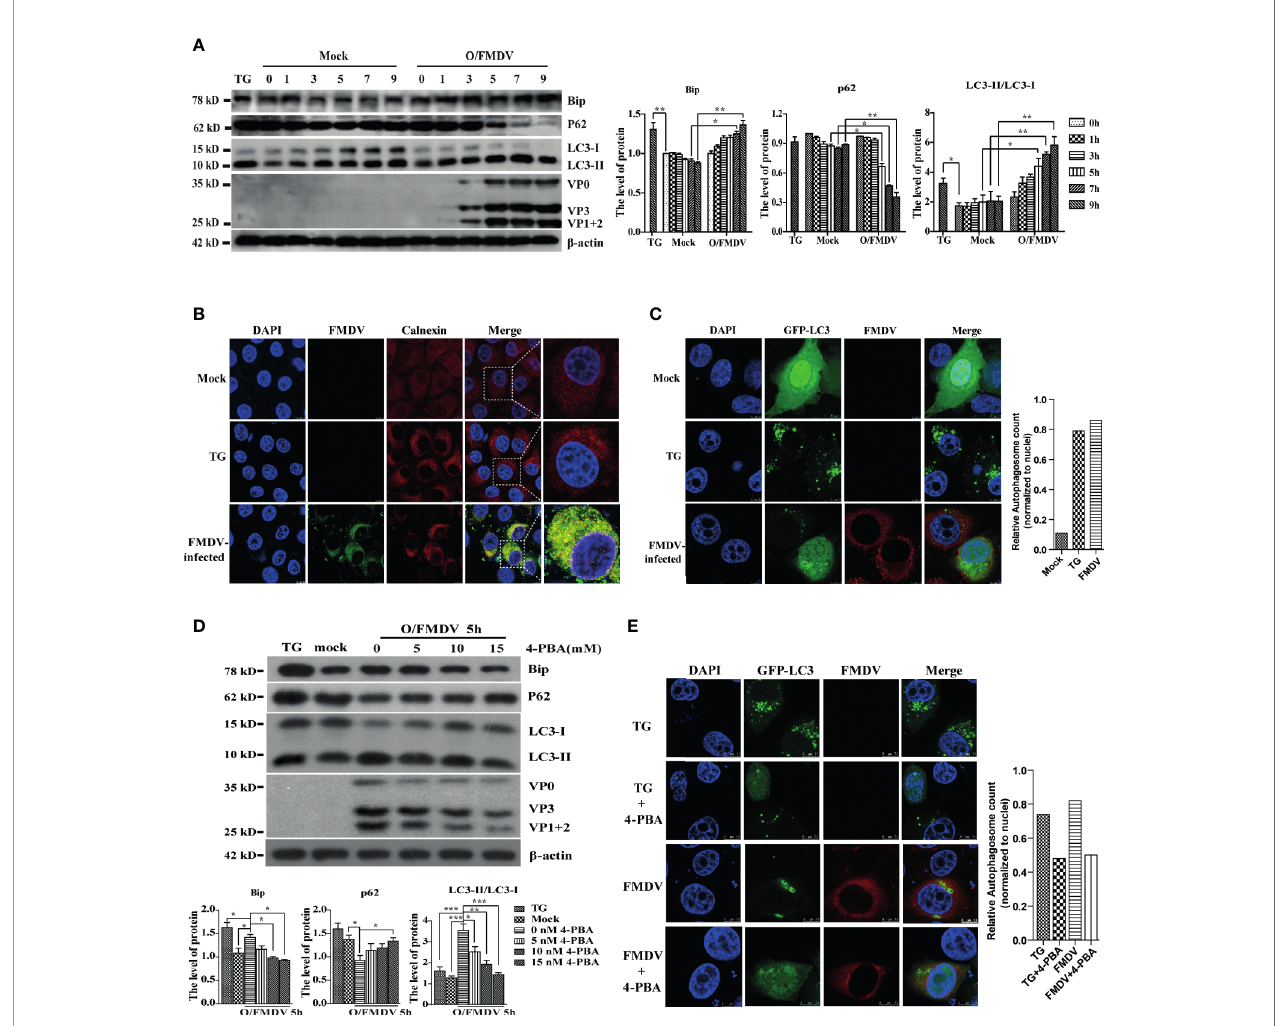
FIGURE 1 | FMDV infection induces ER stress and autophagy activity. (A) The Bip, LC3, P62, and FMDV structure proteins were detected by Western blot at indicated time points. The right graph shows the band intensities of speci fi c proteins by densitometry using ImageJ software. The levels of related proteins were normalized to b -actin; data were expressed as means ± S.D of three experiments. Every treatment group compared with control groups, respectively; * p < 0.05, ** p < 0.01. (B) FMDV-infected and TG-treated cells were fi xed at 9 hpi, and mock-infected cells were used as a negative control. Cells were then imaged using confocal microscopy with a ×100 oil-immersion objective lens to detect the aggregation of calnexin. Calnexin was stained with TRITC, FMDV stained with FITC, and nuclei were stained with DAPI. Scale bars: 7.5 m m. (C) TG-treated and FMDV-infected PK-15 cells were transfected with GFP-LC3 recombinant plasmid and fi xed at 9 hpi for immuno fl uorescence. The GFP-LC3 puncta aggregation was observed under a laser confocal microscope. FMDV and nuclei were stained with TRITC and DAPI, respectively. Scale bars: 7.5 m m. The puncta quanti fi cation was determined by the cells with LC3 fl uorescent puncta normalized to the number of nuclei. (D) PK-15 cells were pretreated with different concentrations of ER stress inhibitor 4-PBA for 3 h and infected with FMDV for 5 h. Cells were collected for detecting the levels of Bip, LC3, and P62 by Western blot. The levels of related proteins were normalized to b -actin; data were expressed as means ± SD of three experiments. Every treatment group compared with control groups, respectively; * p < 0.05, ** p < 0.01, *** p < 0.001. (E) the GFP-LC3 puncta aggregation was imaged by laser confocal microscope. FMDV was stained with TRITC and nuclei with DAPI. Scale bars: 7.5 m m. The puncta quanti fi cation was determined by the cells with LC3 fl uorescent puncta normalized to the number of